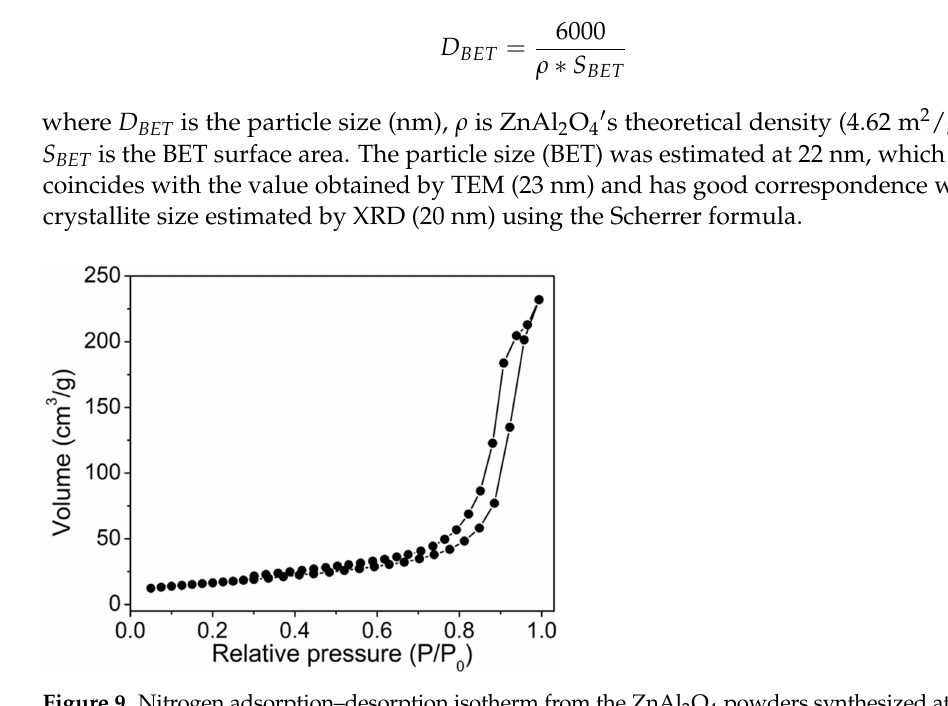
Figure 9. Nitrogen adsorption–desorption isotherm from the ZnAl 2 O 4 powders synthesized at 700 ◦ C.